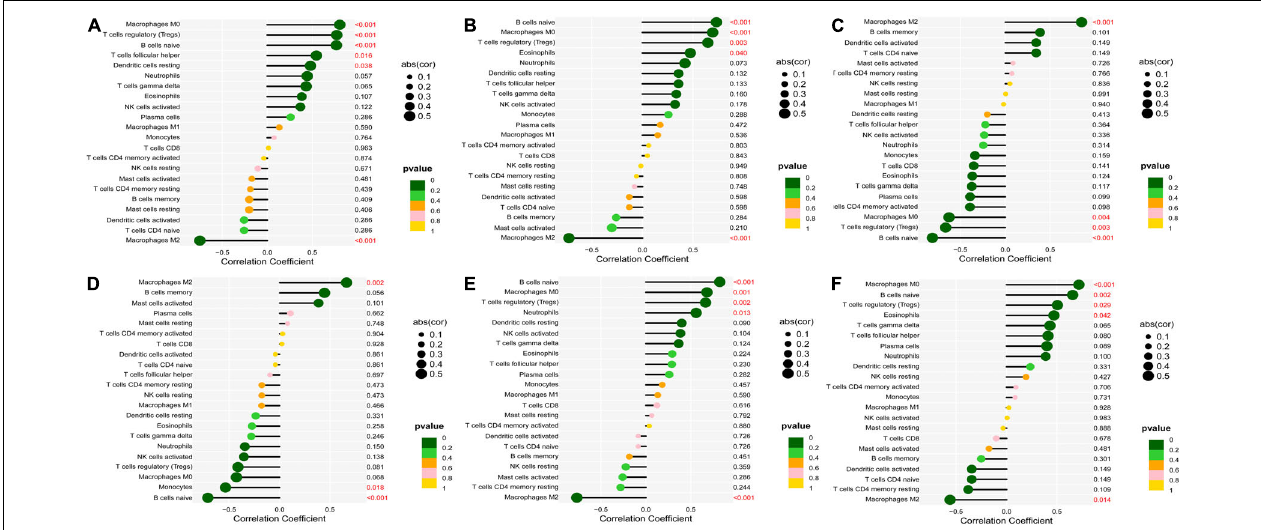
FIGURE 10 | Correlation between validated hub genes and immune cells. (A) SPP1, (B) TREM1, (C) GPM6A, (D) CNTN1, (E) TLR8, and (F) SDC1. The x- axis represents the correlation coefficient, the left y -axis represents immune cells, the right y -axis represents P -value. The solid dots represent the relative quantity of the correlation coefficient. The color gradation represents the relative quantity of the P -valve. Pearson’s test was used for correlation